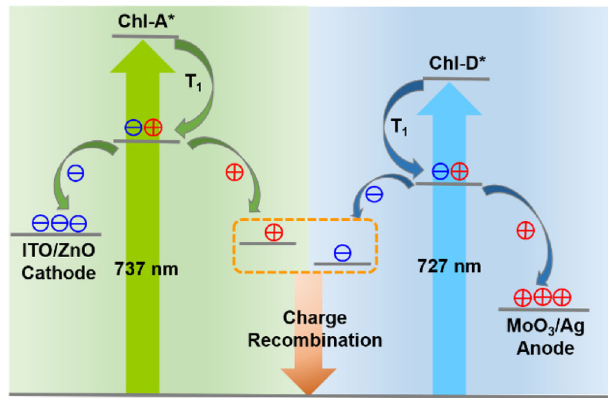
Fig. 7 Analytic model used for the Chl-A and Chl-D inspired bio-solar cell. Model used for the Chl-A and Chl-D excitation dynamics, charge transfer, and recombination processes occurring in the Z-scheme process of an oxygenic photosynthesis inspired bio-solar